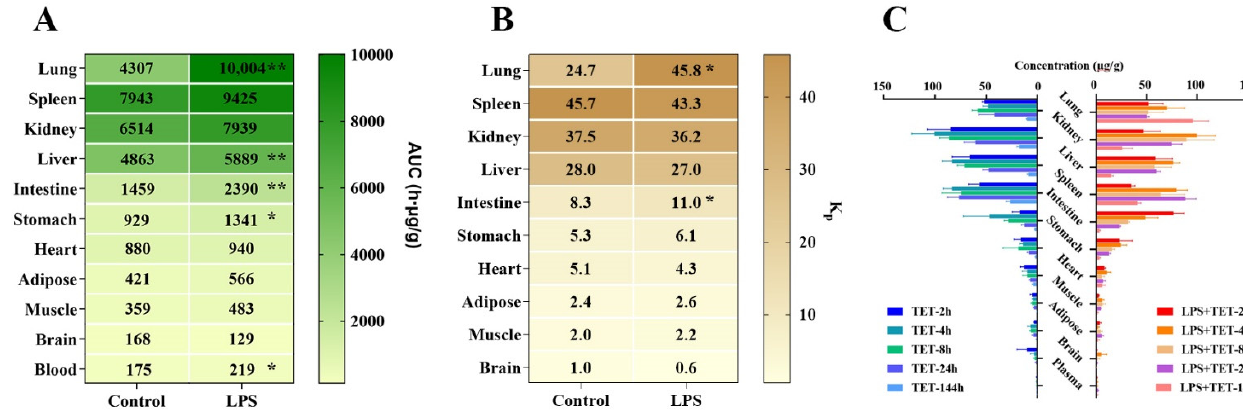
2591 ± 271 ** 4089 ± 3400 1645 ± 323 816 ± 429 674 ± 240 179 ± 38.4 326 ± 12.9 * MRT